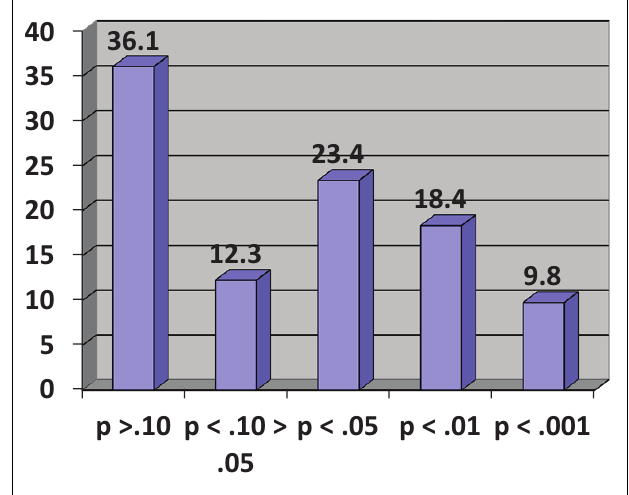
FIGURE 1 | Frequency histogram of p -values (%) for 1,500 simulated experiments (see text) . Adapted from Cumming ((11), p.